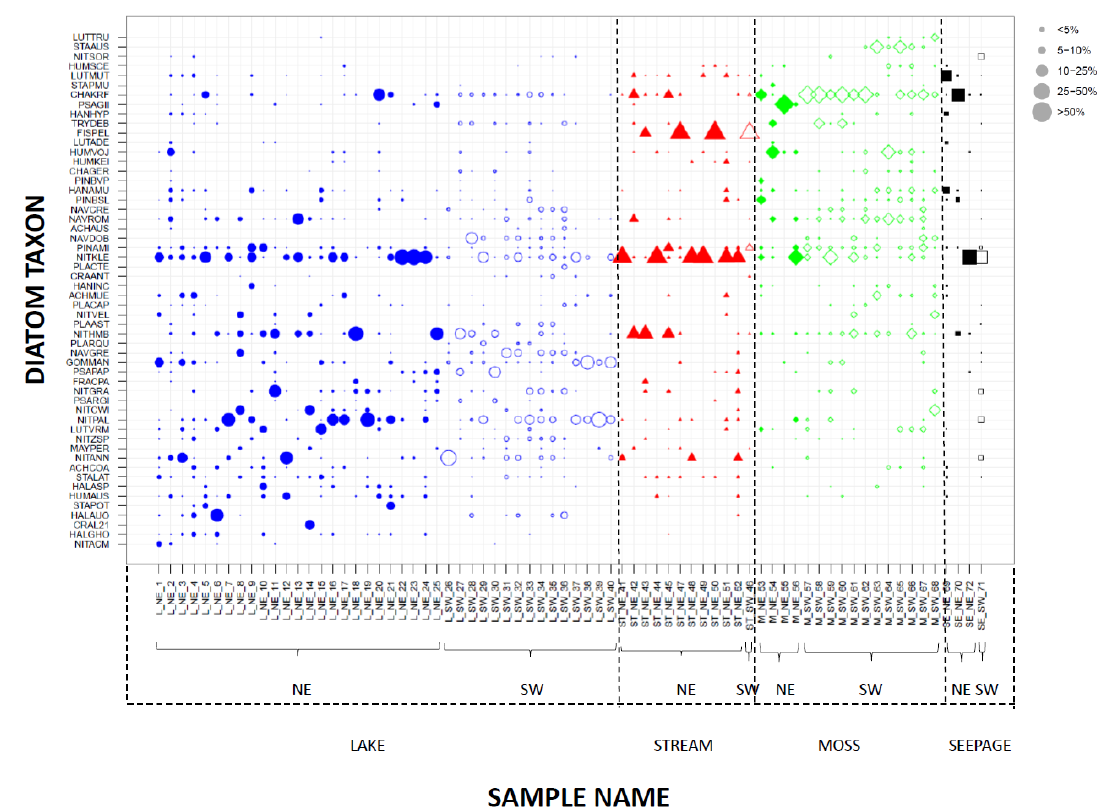
Figure 4. Dot plot representation of relative abundance counts averaged by sample. Site codes are on the x-axis, and species codes are on the y-axis. The size of a dot is proportional to the relative abundance of a particular species in a given sample. Only diatoms with relative abundances > 4 % are plotted. Pond habitats are indicated by blue circles, moss habitats by green diamonds, seepages by black squares, and streams by red triangles. Symbols for Devil’s Bay are filled, and Cape Lamb sites are represented by outlines only. The key for species abbreviations are available in Table S2 and site names in Table S1.